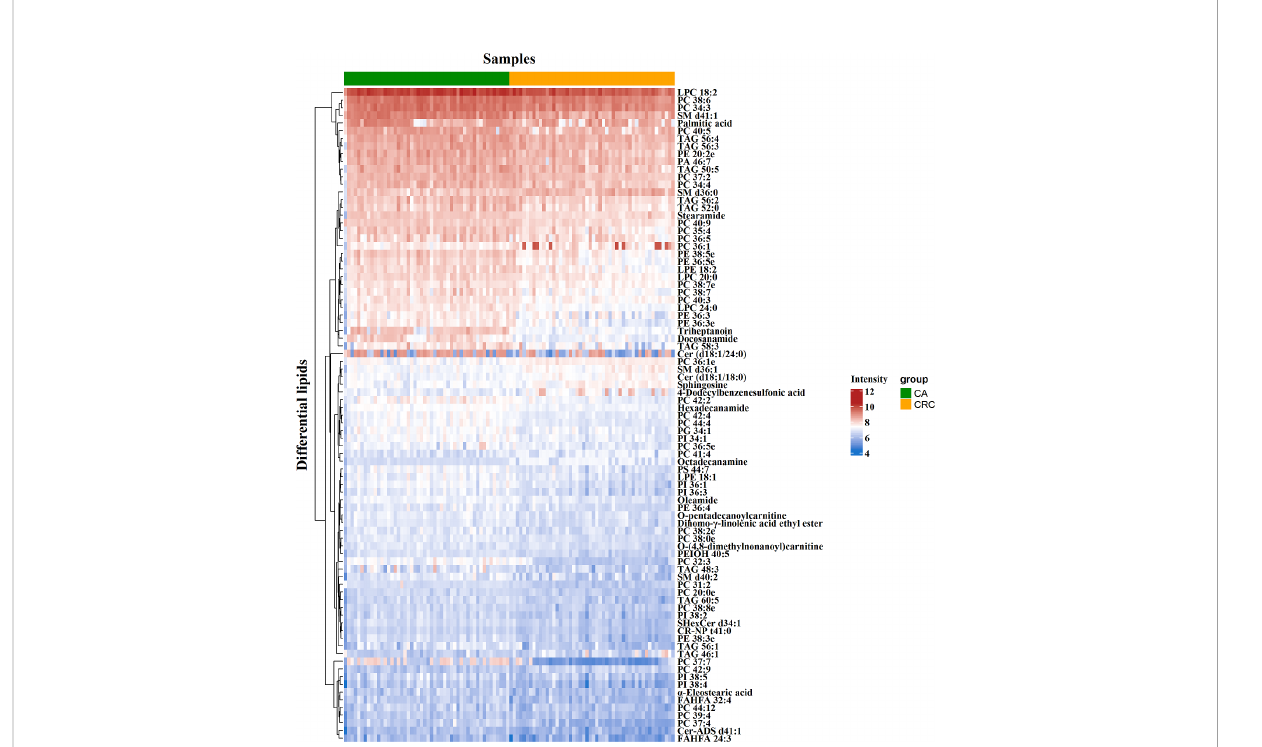
FIGURE 4 Clustering heatmap analysis of 85 differential lipid species between CA and CRC groups. The color bars represented the log10 value of the ratio for each lipid species and only statistically signi fi cant changes were shown (fold change > 1.50 or < 0.67 and P <